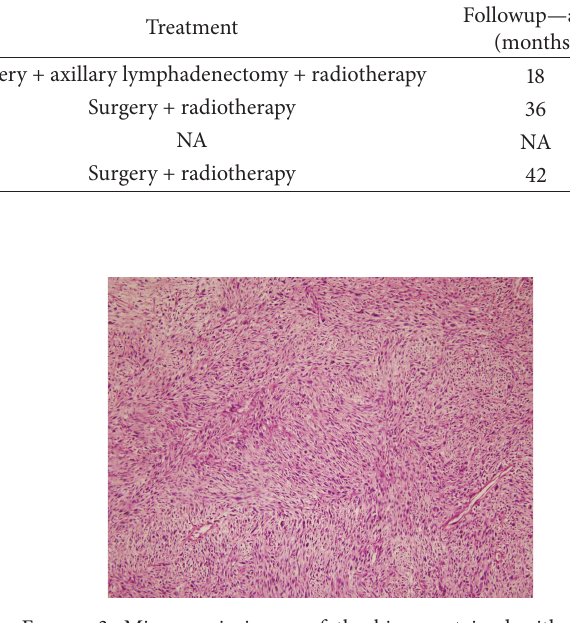
Figure 1: Microscopic image of the biopsy, stained with H&E; storiform pattern indicated malignant fibrous histiocytoma near the pectoral muscle (H&E × 20).